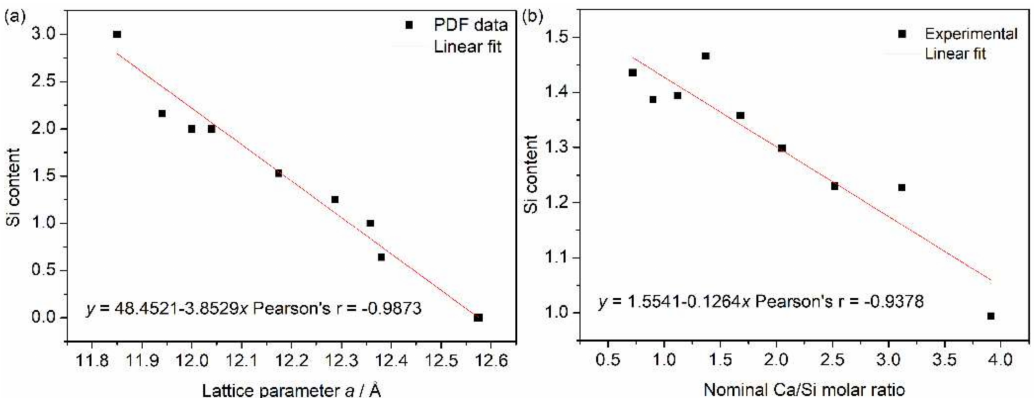
Figure 4. ( a ) Plot of Si content against lattice parameter a of hydrogarnet from the powder diffraction file (PDF) data (see Table S4); ( b ) plot of Si content of hydrogarnet calculated from Equation (1) against nominal Ca/Si molar ratio in the starting material (see Table S5).